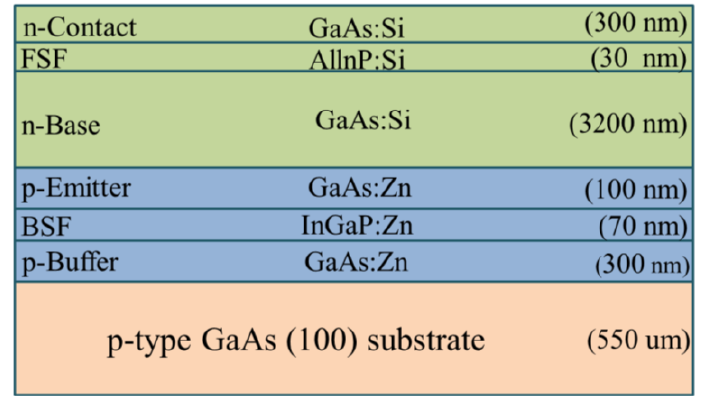
Figure 1. Specifications of epitaxial layers of single-junction GaAs grown via Metal-organic Chemical Vapor Deposition (MOCVD) on a p + -type GaAs (100) substrate.